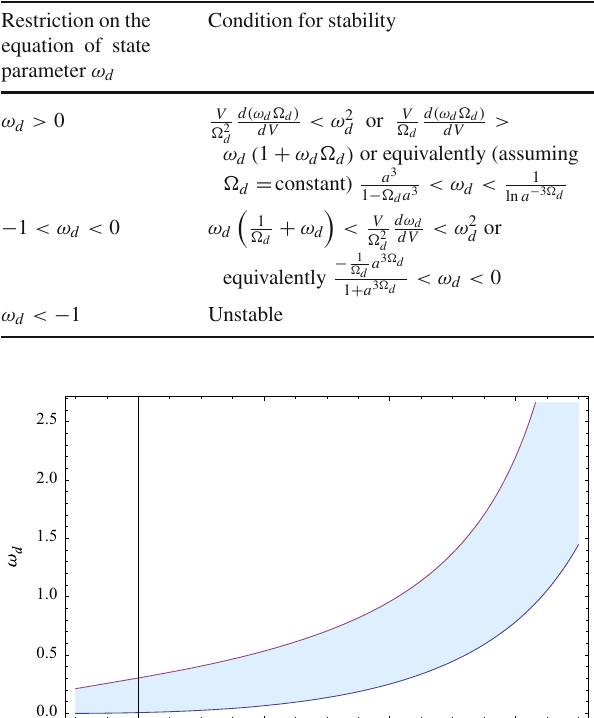
Table 2 Restrictions on DE equations of state for stability criteria